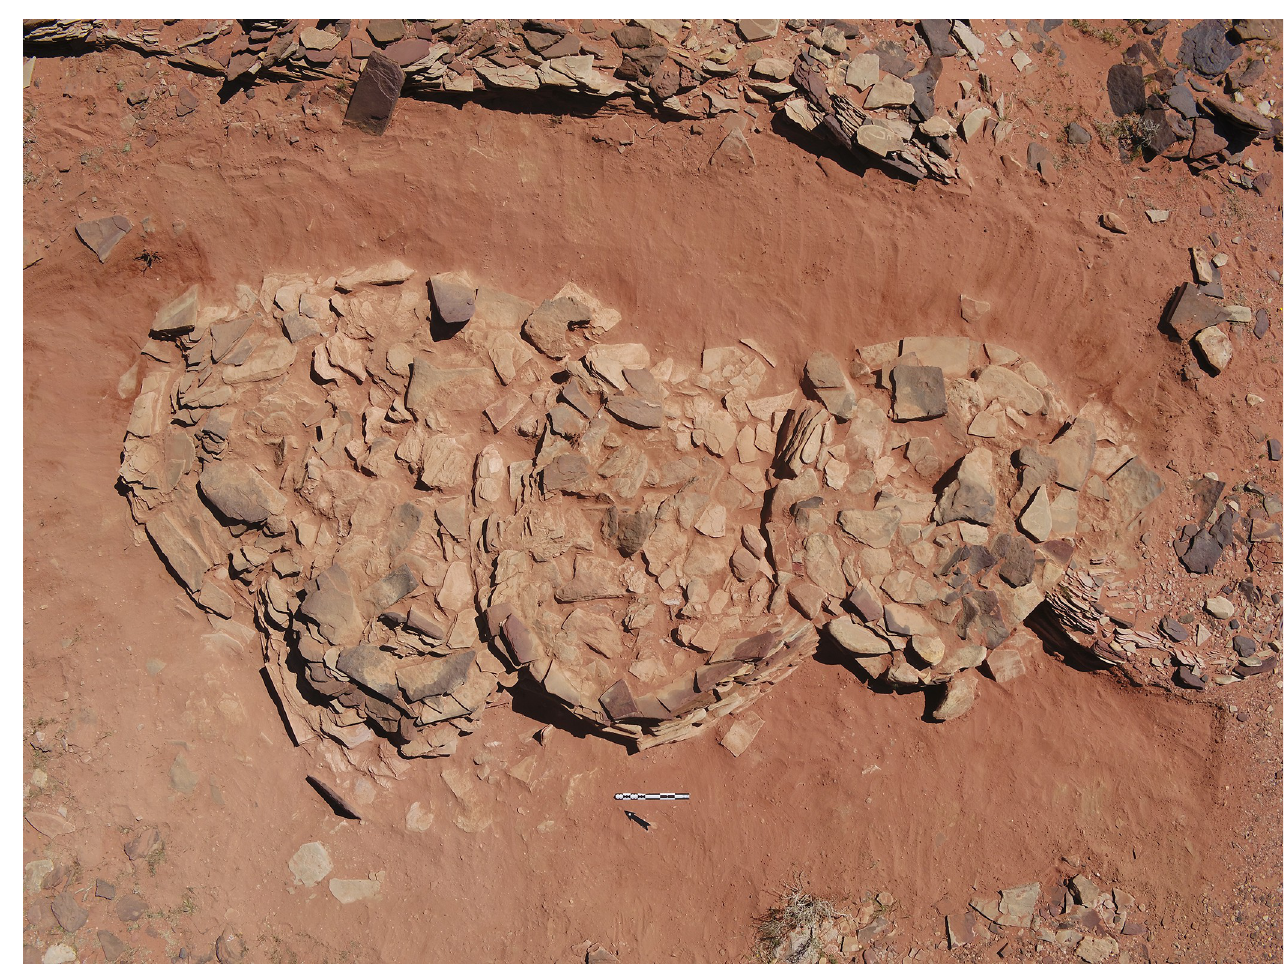
Fig 5. Detail of north-west (preserved) interlocking cells of associated feature IDIHA-F-0011149.